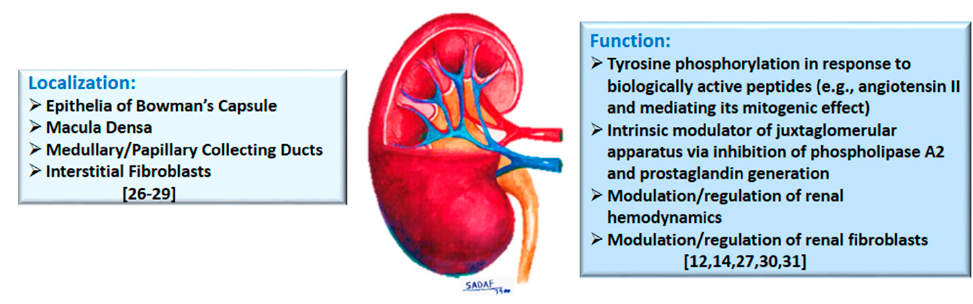
Figure 1. The diagram summarizes localization and physiological functions attributed to Annexin A1 in the kidney; relevant citations are provided in brackets.